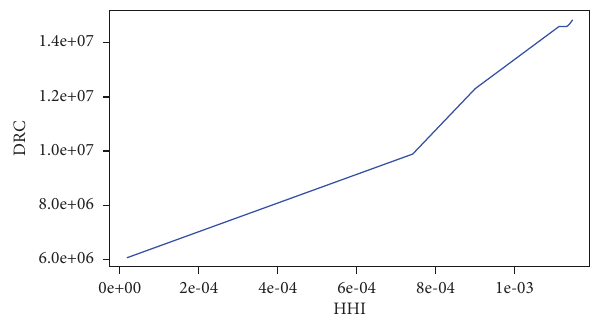
Figure 6: DRC evolution with respect to HHI.